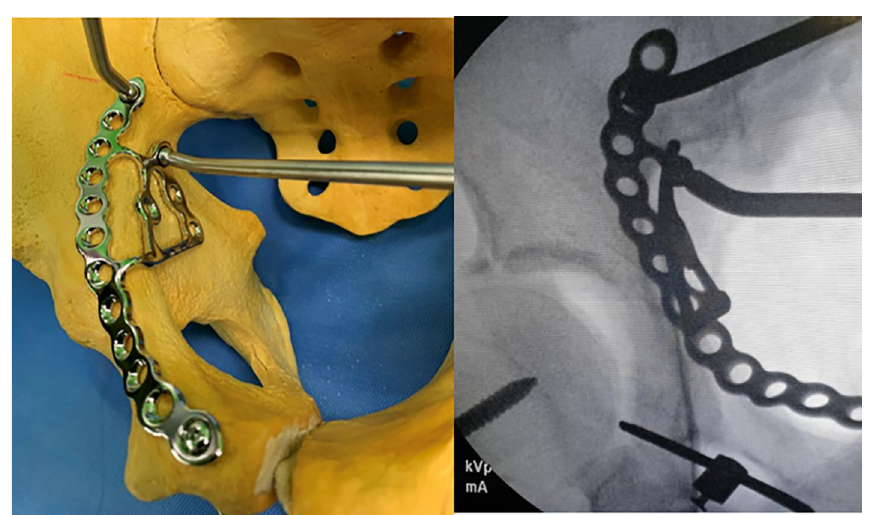
Figure 5. Reduction of the superiorly displaced anterior column using a pusher on the suprapectineal portion of the